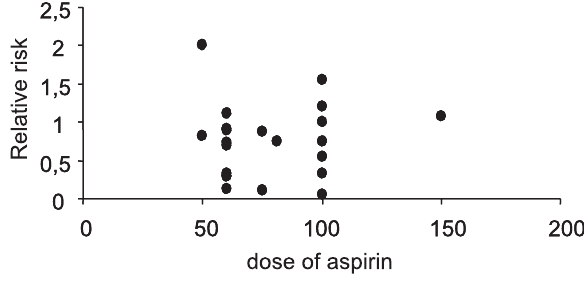
Figure 3 - Correlation between dose of aspirin and relative risk for preeclampsia in each